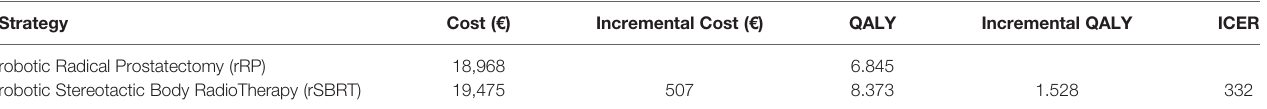
TABLE 2 | Costs and QALYs (Quality Adjusted Life Years) differences between the two strategies (rRP versus rSBRT) in order to estimate the ICER (Incremental Cost Effectiveness Ratio) over a 10-year time horizon. Strategy